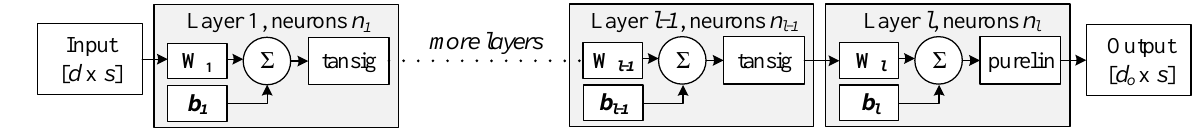
Figure 10: Deep Artificial Neural Network (ANN) with s samples of d dimensions and output dimension d o . The size of input and output layer are governed by d and d o . The hidden layers (grey boxes) have n neurons, and each neuron consists of a weight, bias and activation function.